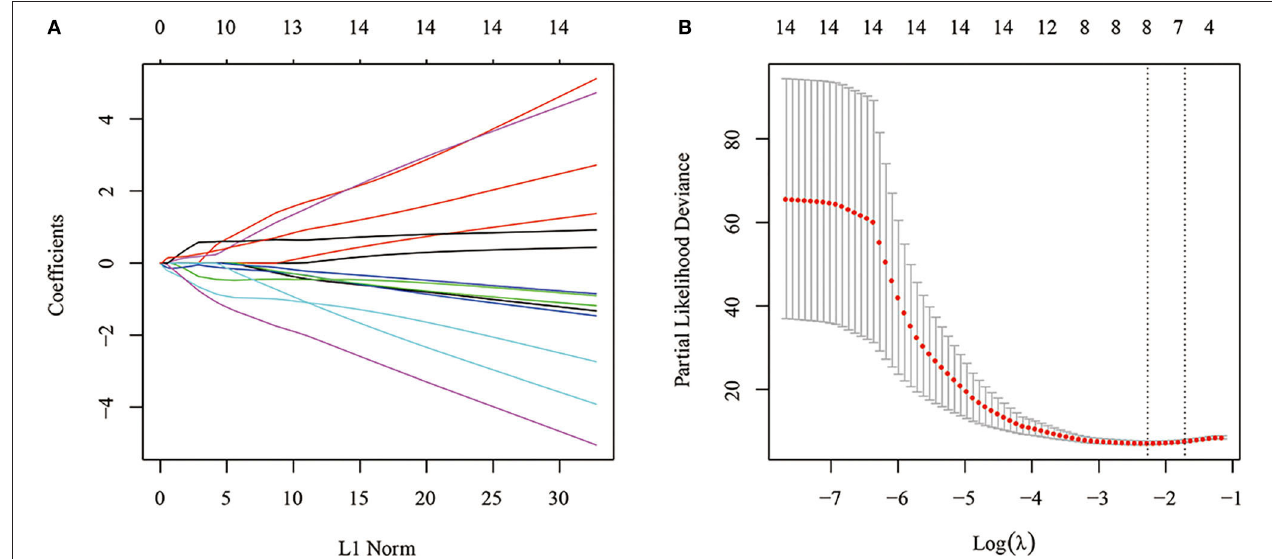
FIGURE 4 | (A) Change trajectory of each independent variable. The horizontal axis represents the log value of the independent variable lambda, and the vertical axis represents the coefficient of the independent variable. (B) Confidence intervals under each